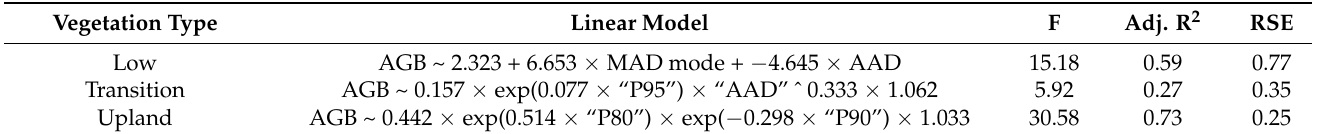
Table 2. Regression models for aboveground biomass (AGB) relating survey estimated AGB for three vegetation types and forest metrics calculated with airborne lidar data.